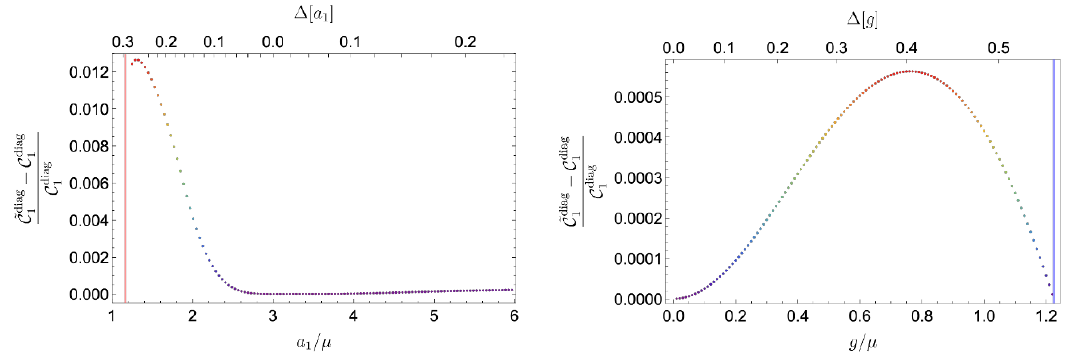
Figure 7 . The relative di(cid:11)erence between the mode-by-mode ‘complexity’ ~ C diag complexity C diag